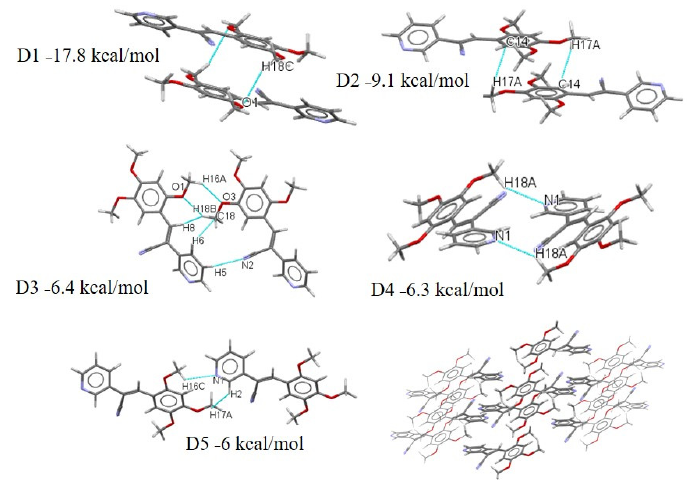
Figure 19. Different dimers (D1–D5) with interactions in the IV crystal structure with respective interaction energies.